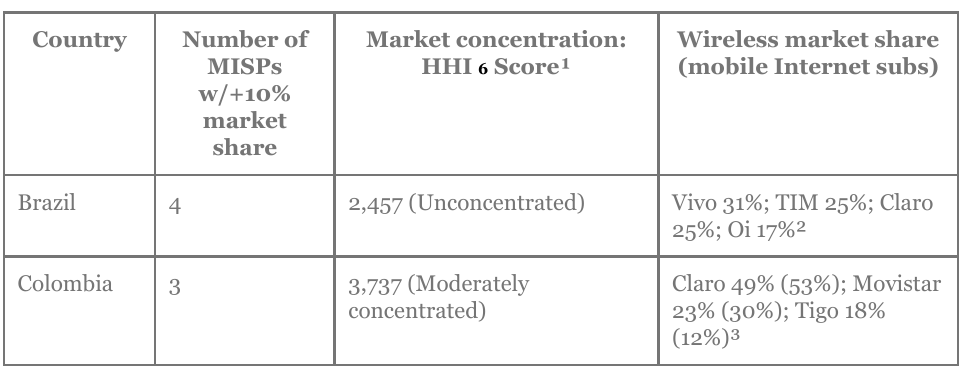
Table 3: Wireless market